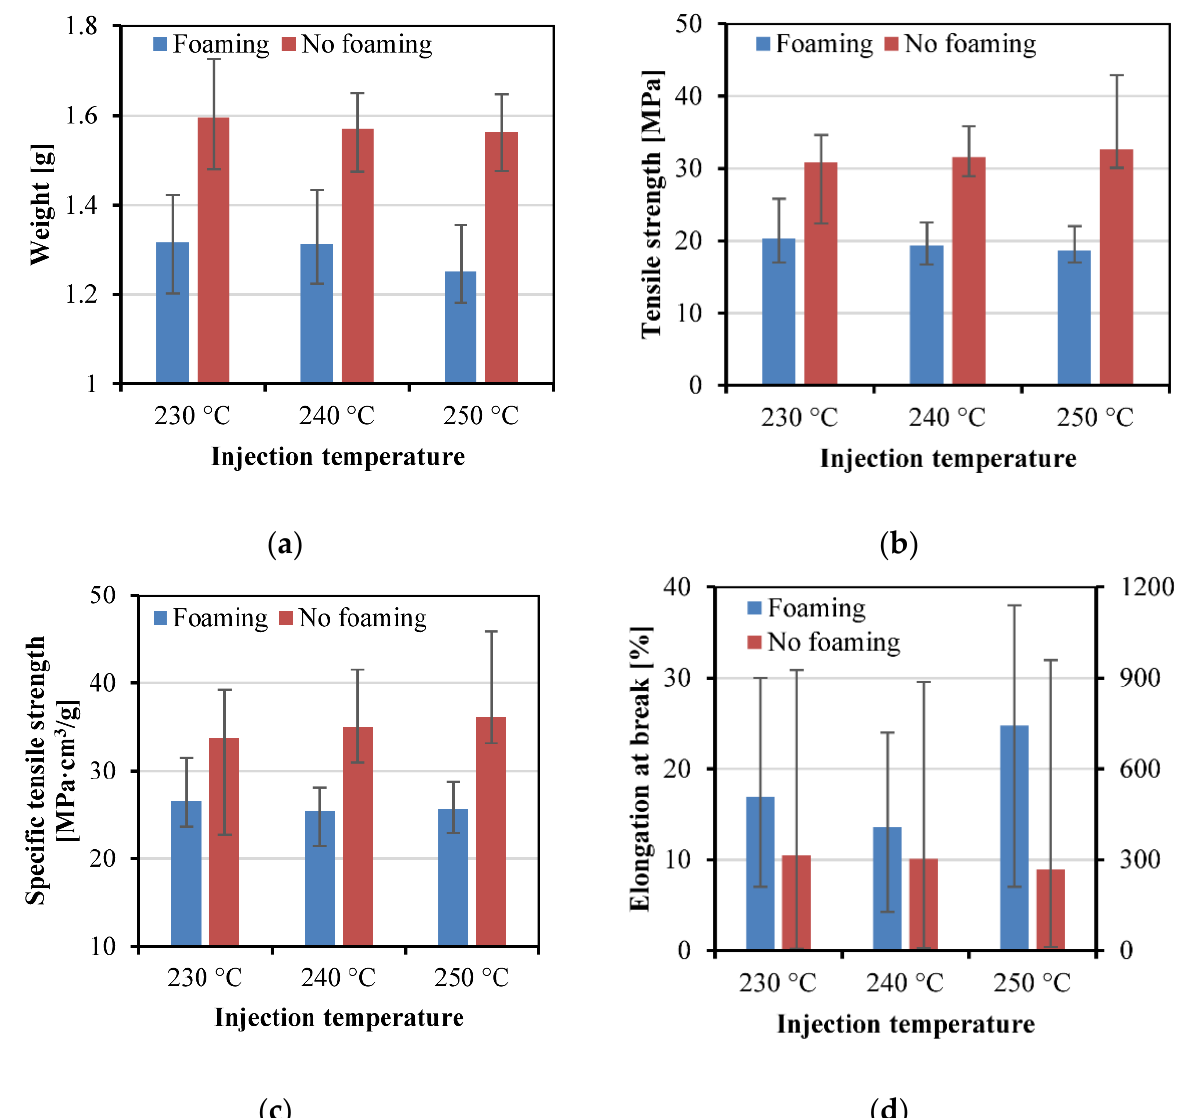
Figure 13. Weight ( a ), tensile strength ( b ), specific tensile strength ( c ), and elongation at break ( d ) of the samples prepared at different injection temperatures.